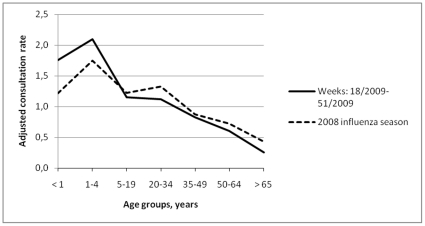
Adjusted sentinel average weekly consultation rate for influenza-like illness by age group in New Zealand, during 2009 (H1N1) pandemic influenza and the previous influenza season.Consultation rate by age group is shown as times X consultation rate for total population.